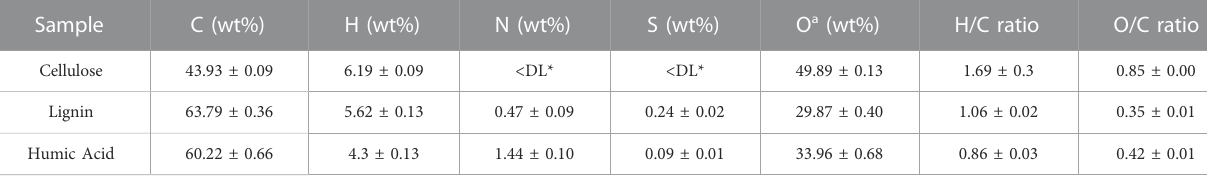
TABLE 5 Elementary analysis of commercial BCs sample at a dry ash-free basis (duplicate sample on average value).